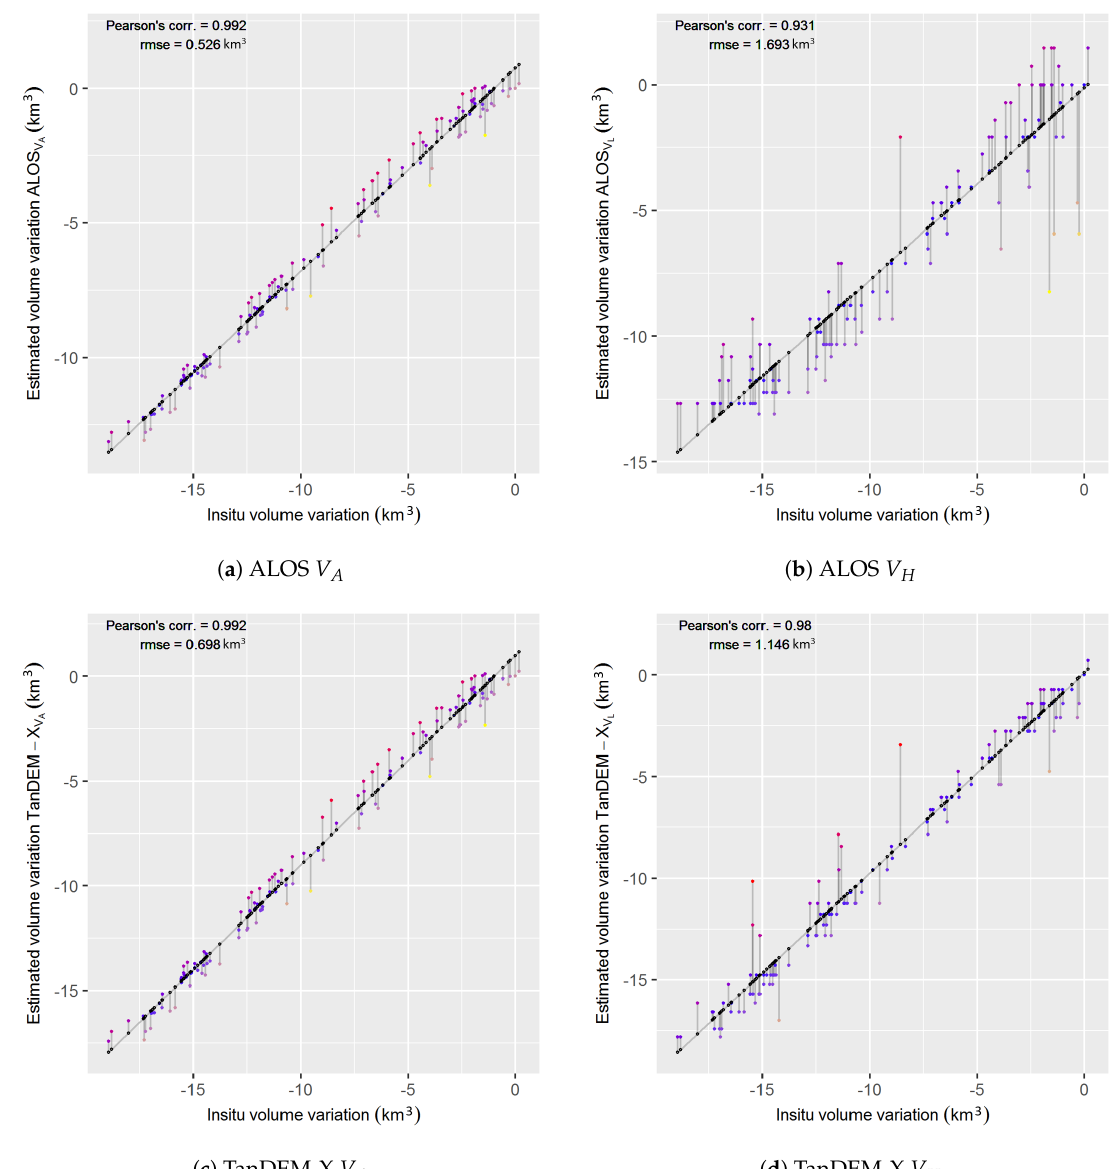
Figure 8. Lake Powell: Relationship between DEM estimated and in situ volume variations. The vertical lines with darker color-codes indicate the lower standard deviation of the residuals from the regression line (lower RMSE). The lighter color-codes indicate higher deviations of estimated values from the in situ values and higher